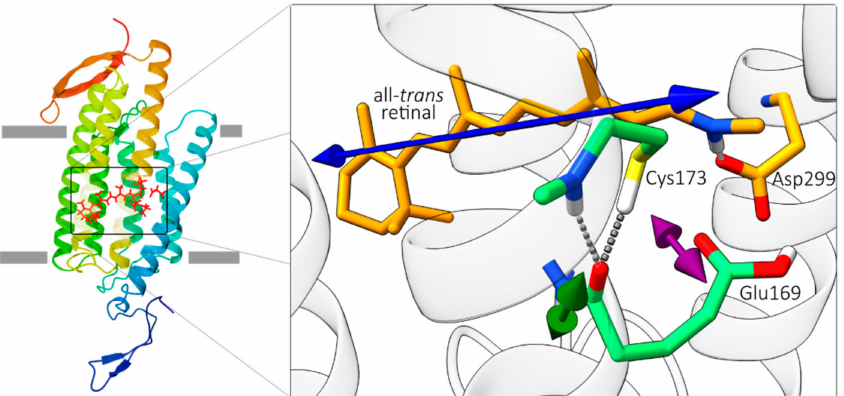
Figure 1. The calculated ground-state structure of Chlamydomonas augustae ( Ca ChR1). For clarity, the figure shows only selected amino acid residues. The blue arrow displays the direction of the calculated electronic transition dipole moment (tdm) of the S 0 to S 1 transition and the green and the purple arrows show the vibrational tdm direction of the amide I mode of Glu169 and of the carboxyl C = O group of